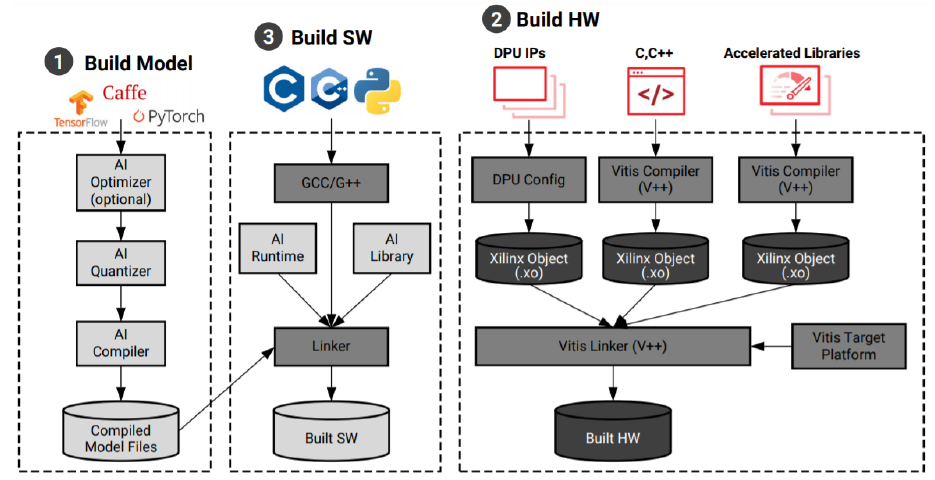
Figure 7. EBCI flow based on Xilinx platforms